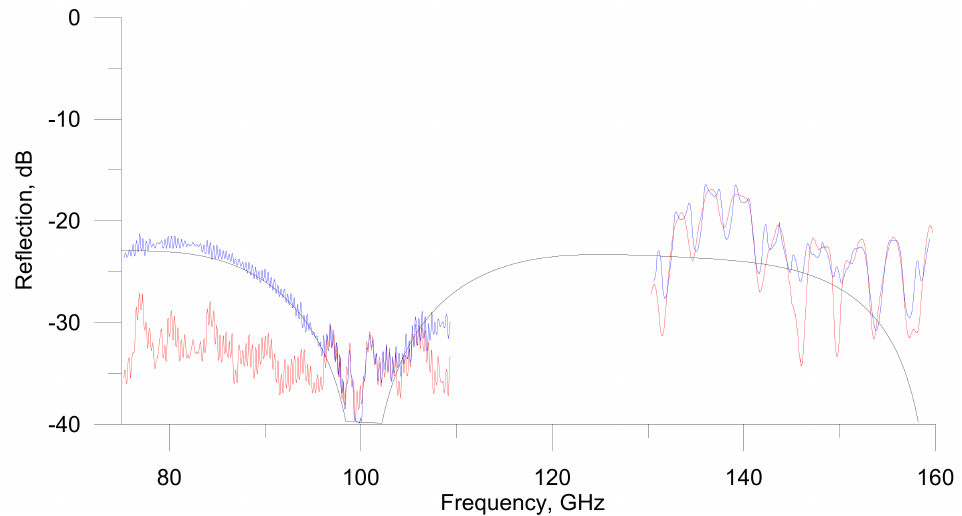
Figure 6. Reflection from the 3D-printed disk with pyramids on both sides. The black line corresponds to the numerical simulation in CST Studio. The blue line is the measured reflection coefficient, and the red line is the lower sensitivity limit of the measurement